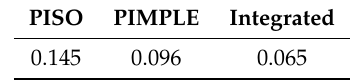
Figure 11. Time evolution of the maximum normalized misfit between observation and CFD solution (with and without correction by the filter). Table 4. Comparison between the χ 2 for the segregated method and the integrated algorithm.